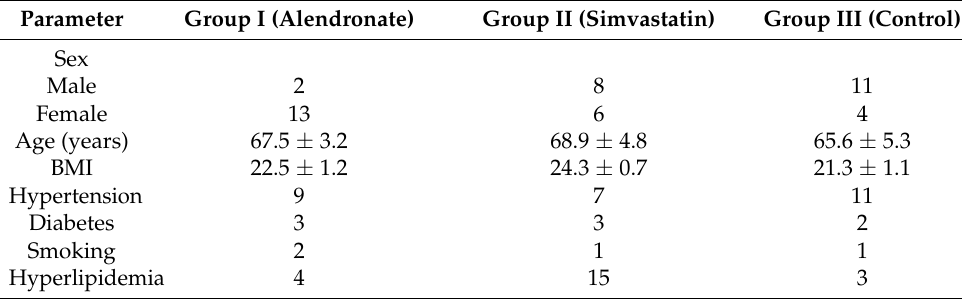
Table 1. Clinical data of patients according to group distribution. Parameter Group I (Alendronate) Group II